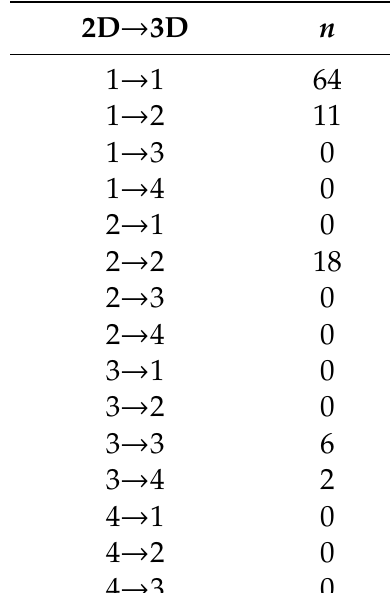
Table 5. The details on agreement and disagreement between 2D and 3D radiographic evaluations. For example, ‘1 → 2 (cid:48) indicates that it was scored as 1 in 2D assessment, but scored as 2 in 3D assessment, and this case was considered as a disagreement case.